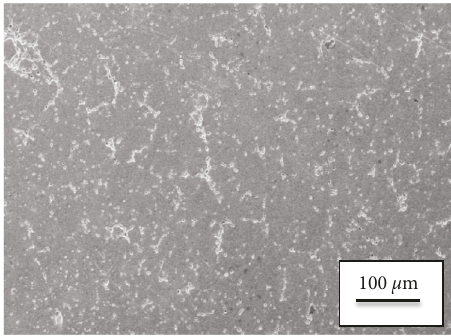
Figure 10: Microstructure image of the tensile fractured surface for a significant parameter (S4-T1-R1-P4).